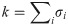
Performance of model in reproducing spiking statistics.(A – C) Low-order moments predicted by the model (y-axis) vs. measured in the data (x-axis). Each data point is an average over an adaptive bin chosen to contain at least 100 cell pairs (B), or triplets (C). Error bars represent ±1 standard deviation. Shaded blue band indicates the 95% confidence interval. (D) Model prediction of individual word probabilities. Words that occurred fewer than 4 times in the data are omitted, as is the all-silent state (whose predictive accuracy is visible in (F)). The blue band indicates the 95% confidence interval, dashed line represents equality. (E) Comparison of model-predicted with empirical word frequencies, extended to include all observed words except the silent state. The gray band represents the range of values for synthetic data sampled from the fit model, with the number of samples matched to the test set (parametric bootstrap). This exhibits almost as much scatter as the true data, even though the model is exactly correct in this synthetic case. (F) Model prediction of population spike-count distribution P(k), where k=∑iσi. Inset: same data as main panel, but with the y-axis log-scaled. Note the close match in the tail of the distribution, which corresponds to very rare events. All goodness-of-fit statistics displayed in this figure were calculated on a 50% held-out test set.